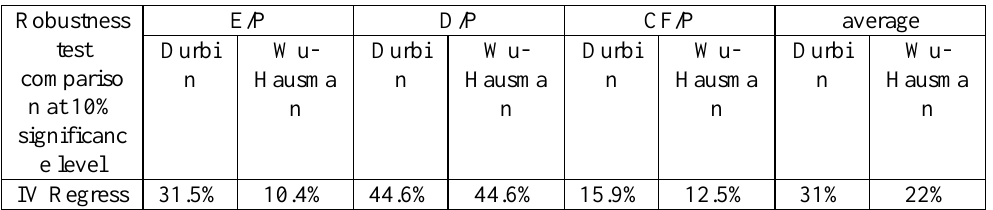
Table 4. Robustness Tests Summary